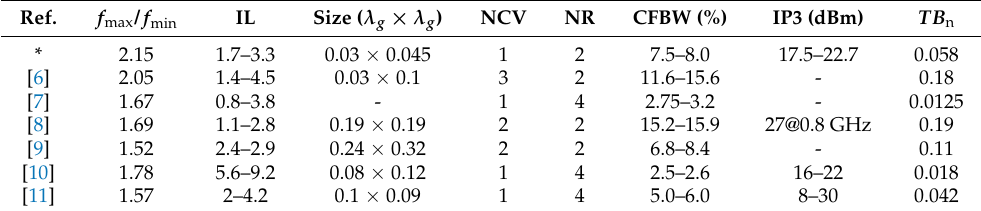
Table 2. Comparison between the proposed and reference